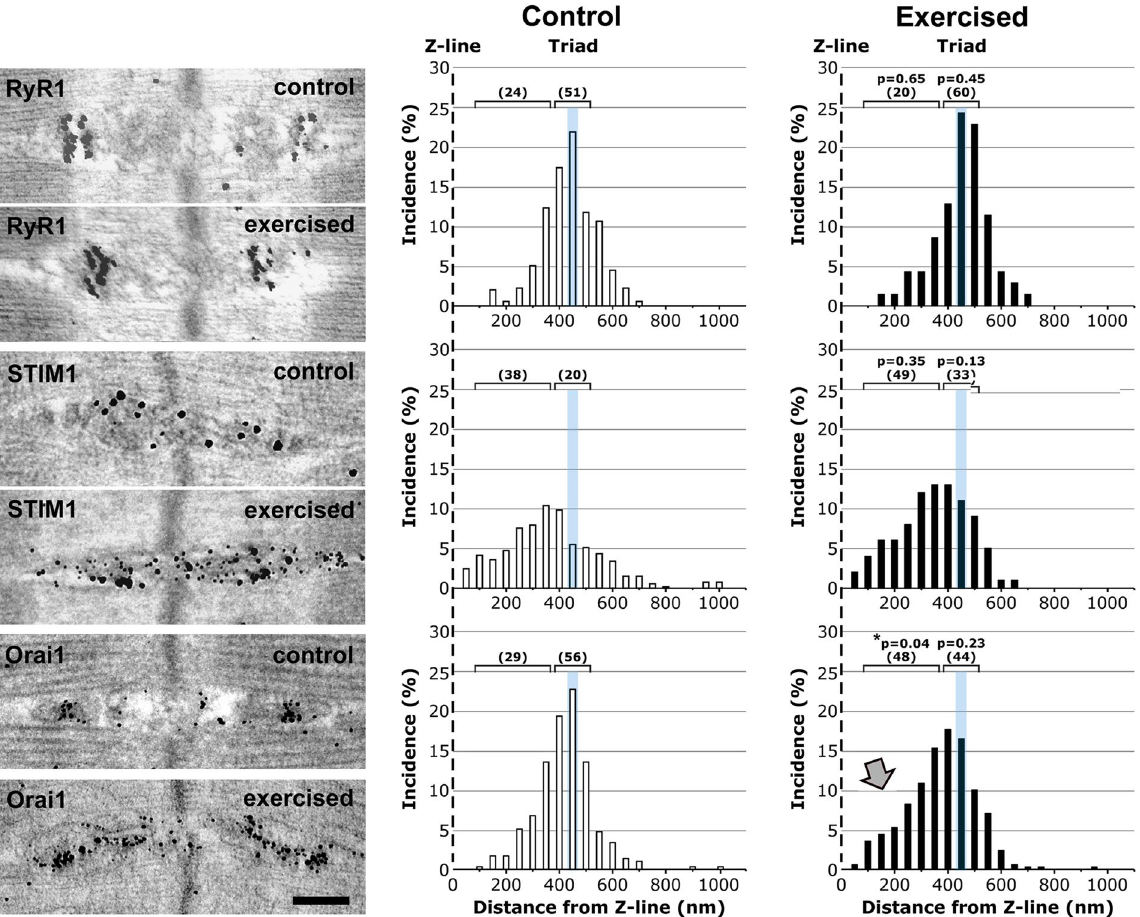
Figure 4. Immunogold labeling shows i) preferential I band localization of STIM1 and ii) increased presence of Orai1 at the I band following exercise. Left) Representative immunogold EM images showing the localization of RyR1 (top), STIM1 (center), and Orai1 (bottom) under control and exercised conditions. Right) Histograms of distances of immunogold particles from the Z line. The cyan line marks the position of the TT at the triad. Brackets with numeric values indicate the percentage of gold particles that fall within the triad-area vs. those that fall within the I-band area. Grey arrow points to the increased presence of Orai1 at the I-band following exercise. Sample size: control, 2 mice/4–8 fibers analyzed; exercised, 3 mice/3–8 fibers analyzed . * p < 0.05. Scale bar: 0.2 µ